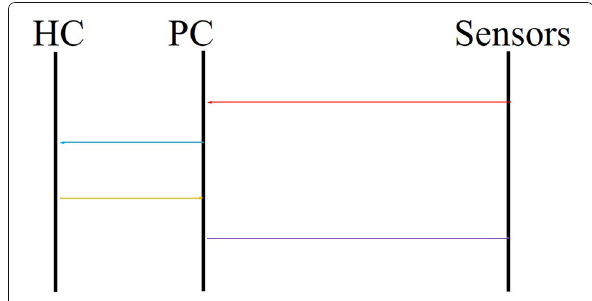
Fig. 2 PC-to-Sensor Mutual Authentication